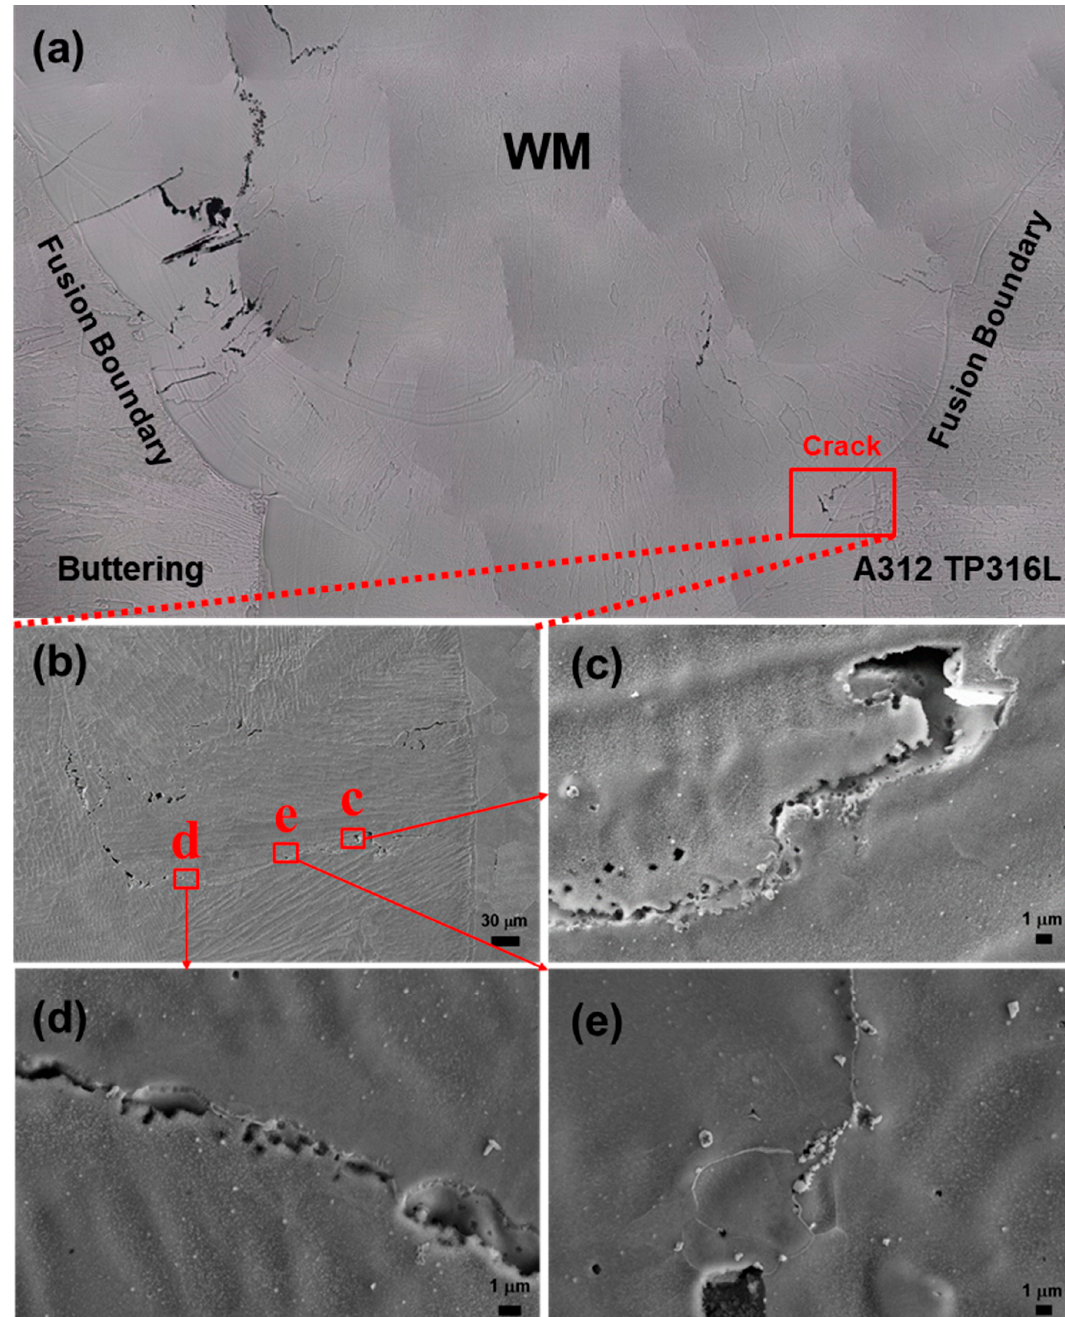
Figure 4. ( a ) A combined figure with several OM figures showing cracks in the WM; ( b ), ( c ), ( d ), and ( e ) SEM micrographs with different magnifications